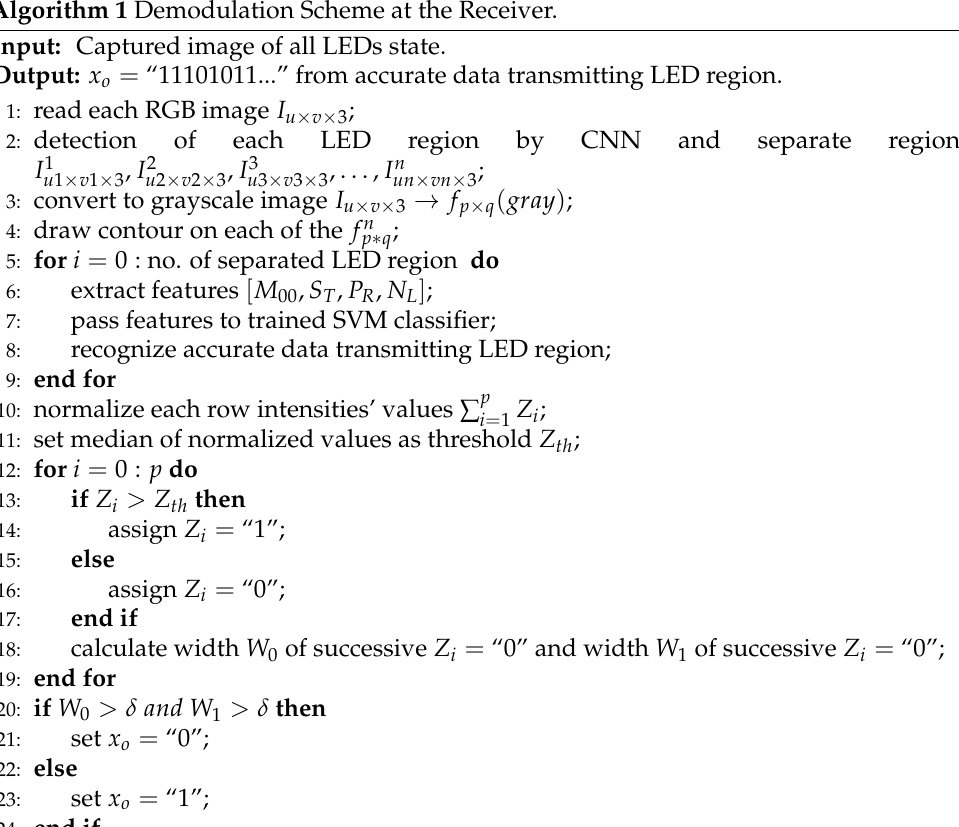
Algorithm 1 Demodulation Scheme at the